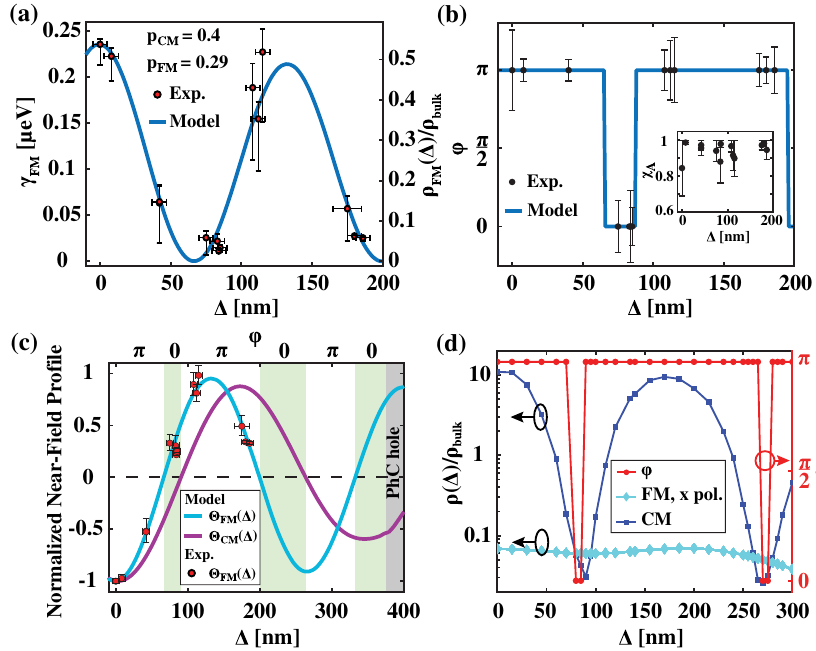
Δ Þ and the corresponding LDOS ρ Δ Þ in units of homogeneous LDOS in bulk GaAs FIG. 5. (a) Direct X − -FM emission rate γ FM ð FM ð Δ Þ and relative phase φ are matched by the model based on the (right-hand ordinate). Spatial dependences of the experimental ρ FM ð mapped FM spatial profile. (b) The extracted relative phase φ . The CM-FM overlap χ is shown in the inset as a function of QD position A Δ . (c) Normalized electric field profile of free-space modes at half-membrane height reconstructed from the extracted ρ Δ Þ in (a) and FM ð the relative phase φ ð Δ Þ in (b). The CM profile, extracted from the 2D FDTD simulations in Fig. 1(c), is shown for reference. Green and white areas in (c) correspond to φ ¼ 0 and π , respectively. Gray region denotes a side view of the PC hole [see Fig. 1(a)]. (d) Relative phase φ , CM, and x -polarized FM LDOS ρ ð Δ Þ relative to the bulk LDOS as a function of Δ calculated using 3D